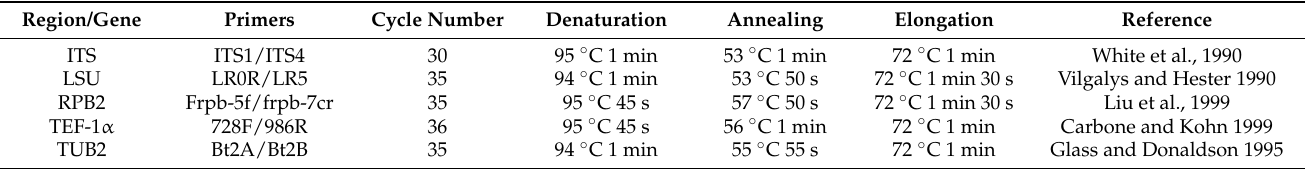
Table 2. PCR thermal cycling